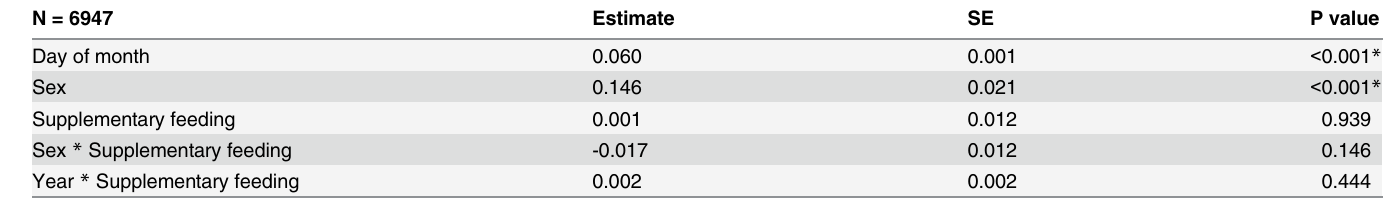
Table 2. Fixed effects model output of the general linear model to explain the effect of supplementary feeding on April API of pink-footed geese Anser brachyrhynchus . Presented estimates are coefficients from a model with “ Year ” and “ Bird ID ” as random effects and “ Day of month ” , “ Sex ” , “ Supple- mentary feeding ” , “ Sex * Supplementary feeding ” and “ Year * Supplementary feeding ” as fixed effects. The supplementary feeding variable distinguishes between birds with API assessments inside and outside areas with supplementary feeding, and N indicates the number of geese included in the analysis. Day of month and Year was fitted as continuous variables